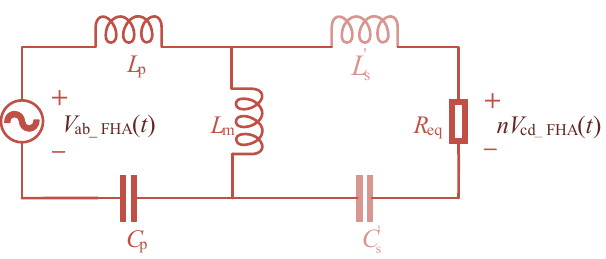
Figure 5. Forward equivalent circuit model of bidirectional CLLLC resonant converter.